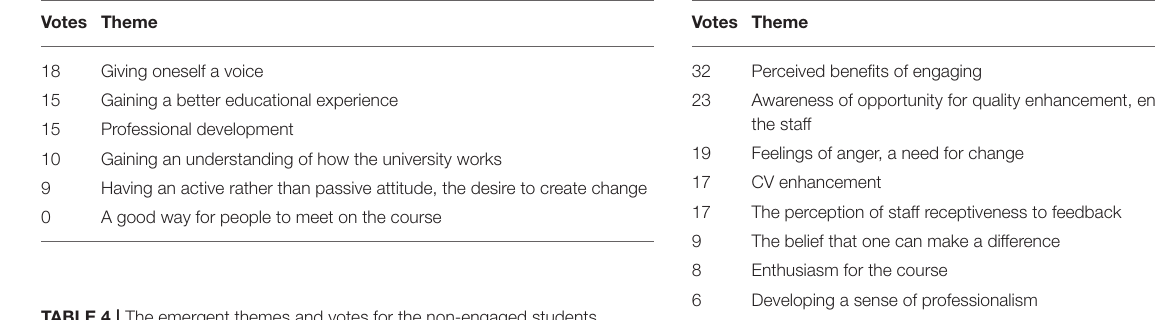
TABLE 3 | The emergent themes and votes for the engaged students.